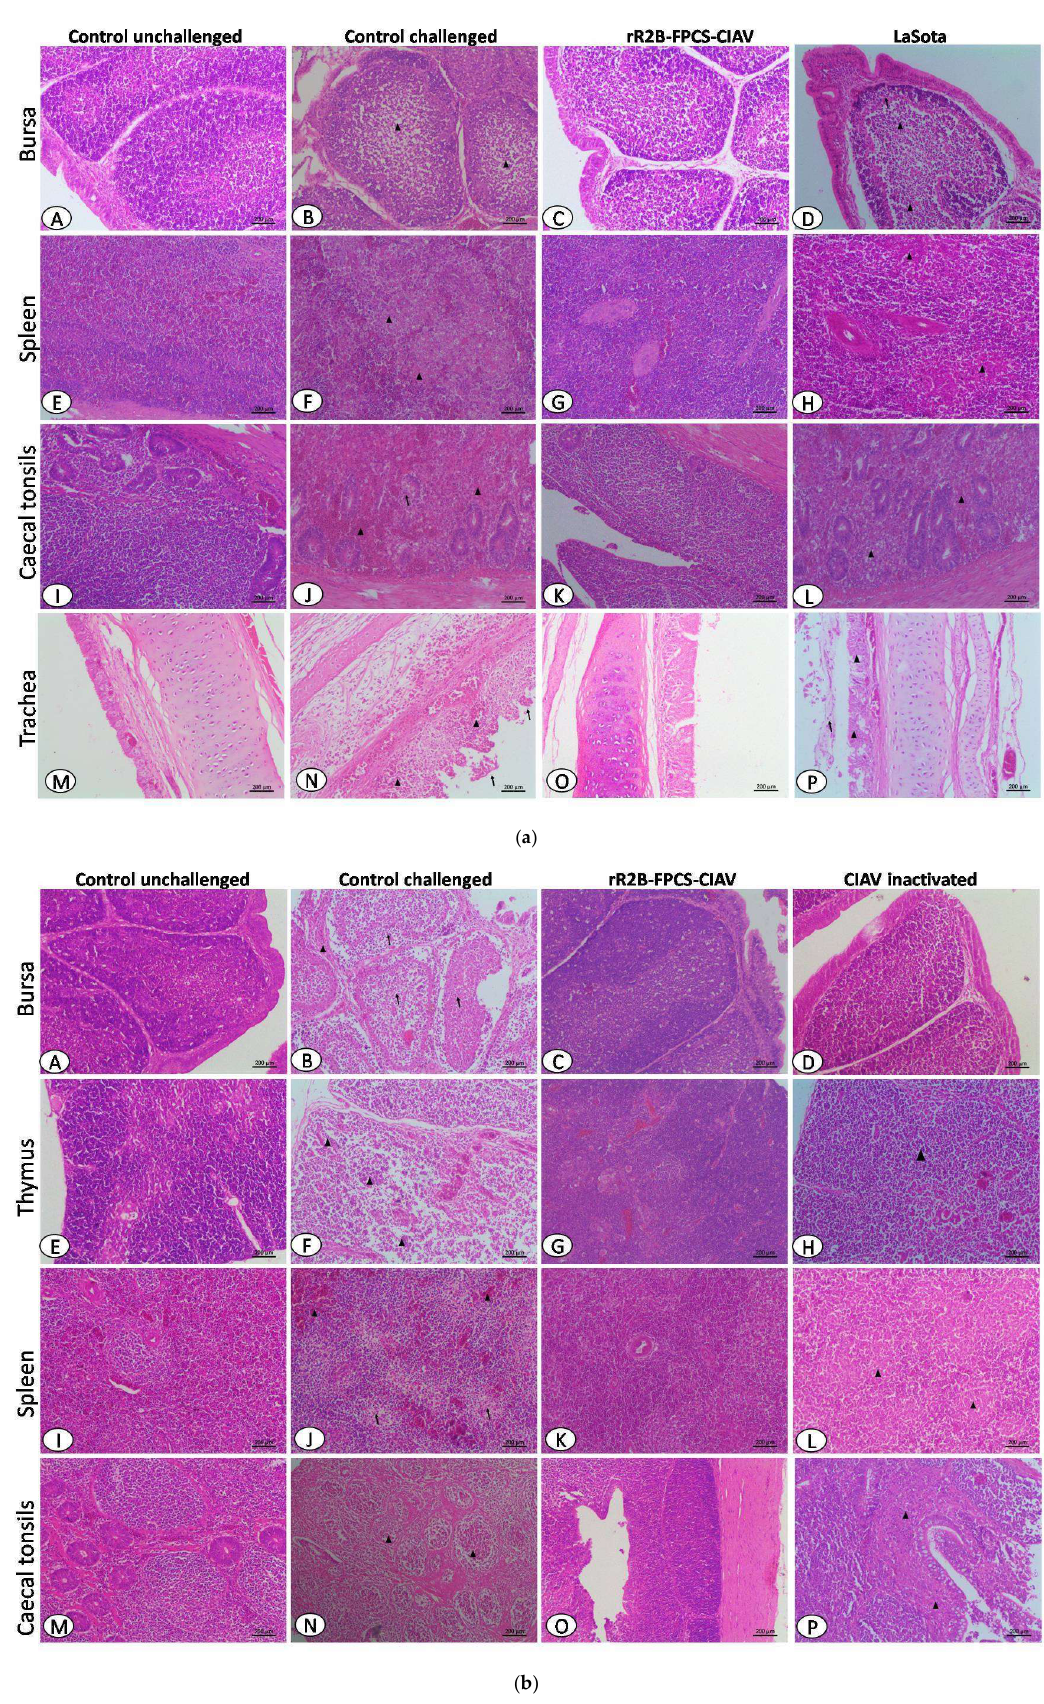
Figure 9. ( a ) Histopathological changes in various immune organs and trachea following virulent NDV challenge. A–D: bursa of Fabricius, H&E 10×, A: apparently normal bursa with intact follicles and plical epithelium, B: bursal follicles with severe lymphoid depletion in the medulla (arrow head), C: apparently normal bursa with intact follicles, D: thinning of cortex (arrow) and mild lymphoid depletion in the medulla (arrow). E–F: spleen, H&E 10×, E: apparently normal splenic architecture with intact PALS and PELS, F: severe lymphoid depletion with severe RE cell hyperplasia (arrow head), G: apparently normal splenic architecture, H: mild lymphoid depletion with RE cell hyperplasia (arrow head). I–L: caecal tonsils H&E 10×, I: apparently normal lymphoid aggregations in the caecal tonsils, J: severe lymphoid depletion with associated haemorrhages (arrow head) along with degeneration of the tonsillar cryptal lining epithelium (arrow), K: ap- parently normal lymphoid aggregations in the caecal tonsils, L: mild lymphoid depletion with RE cell hyperplasia (arrow head). M–P: trachea H&E 10×, M: apparently normal tracheal histoarchitecture, N: necrosis and denudation of tracheal lining epithelium (arrow) with severe inflammatory exudate and haemorrhages in the sub-mucosa (arrow head), O: hy- perplastic lining epithelial cells, P: hyperplastic lining epithelial cells (arrow head) with denudation of mucosa into the lumen (arrow). ( b ) Histopathological changes in various immune organs following virulent CIAV challenge . A–D: bursa of Fabricius, H&E 10×, A: apparently normal bursa with intact follicles and plical epithelium, B: bursal follicles with severe lymphoid depletion in both cortex (arrow) and medulla with mild inter-follicular fibrosis (arrow head), C: apparently normal bursa with intact follicles and plical epithelium compared to control group, D: apparently normal bursal follicles with mild lymphoid depletion in the medulla. E–F: thymus, H&E 10×, E: apparently normal thymic corpuscles with intact cortex and medulla, F: thymic corpuscles showing severe lymphoid depletion in both cortex and medulla (arrow head), G: apparently normal thymic architecture, H: mild lymphoid depletion in the thymic cortex (arrow head). I–L: spleen H&E 10×, I: apparently normal splenic architecture with intact PALS and PELS, J: multifocal areas of haemorrhages in the PALS area (arrow head) with lymphoid depletion (arrow), K: spleen showing mild lymphoid depletion, L: moderate lymphoid depletion with RE cell hyperplasia (arrow head). M–P: caecal tonsils H&E 10×, M: apparently normal lymphoid aggrega- tions in the caecal tonsils, N: moderate lymphoid depletion of the caecal tonsils (arrow head), O: apparently normal lym- phoid cell aggregation in the caecal tonsils, P: very mild lymphoid depletion in the caecal tonsils (arrow head). Scale bar 200 µm